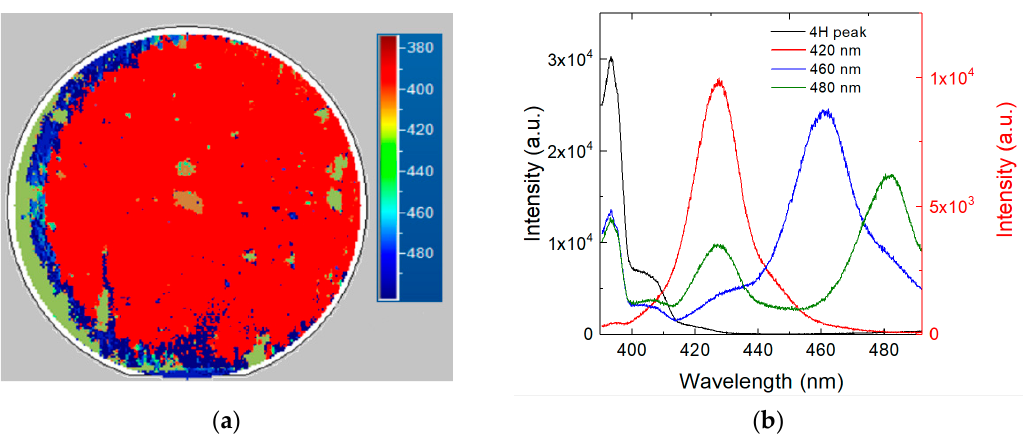
Figure 2. Photoluminescence map ( a ) and relative stacking fault peaks ( b ) of 4H-SiC with epitaxial layer thickness of 250 µm. The black peak represents the band-to-band energy while other peaks are different kinds of SFs, located on the left edge of the wafer. The y-scale on the left is relative to the 4H-SiC region without SFs, while the y-scale on the right is relative to the different SFs.